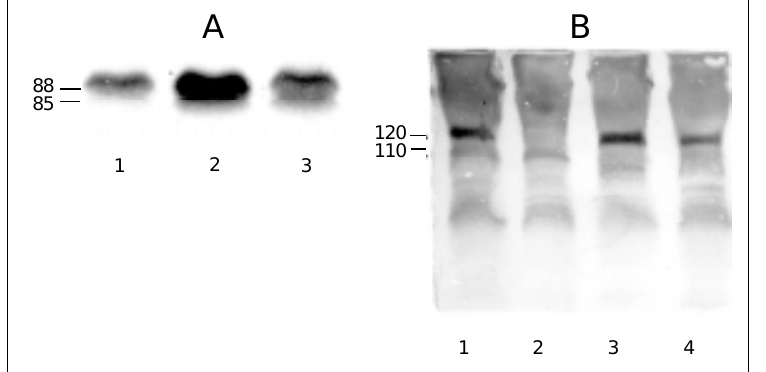
Figure 1 - Western blots of PK and HK (or HK-like species) in PK-deficient, Williams’, normal human,